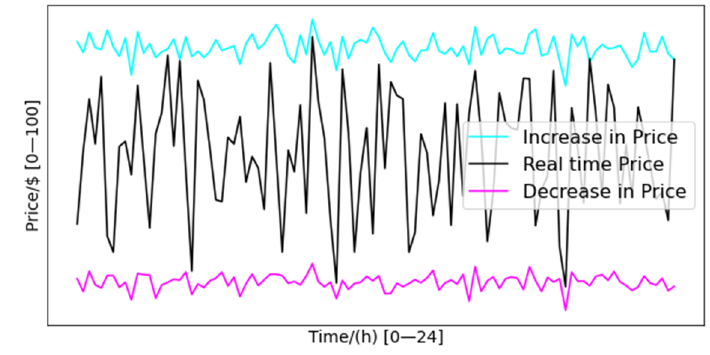
Figure 6. The schematic diagram of real-time prices.